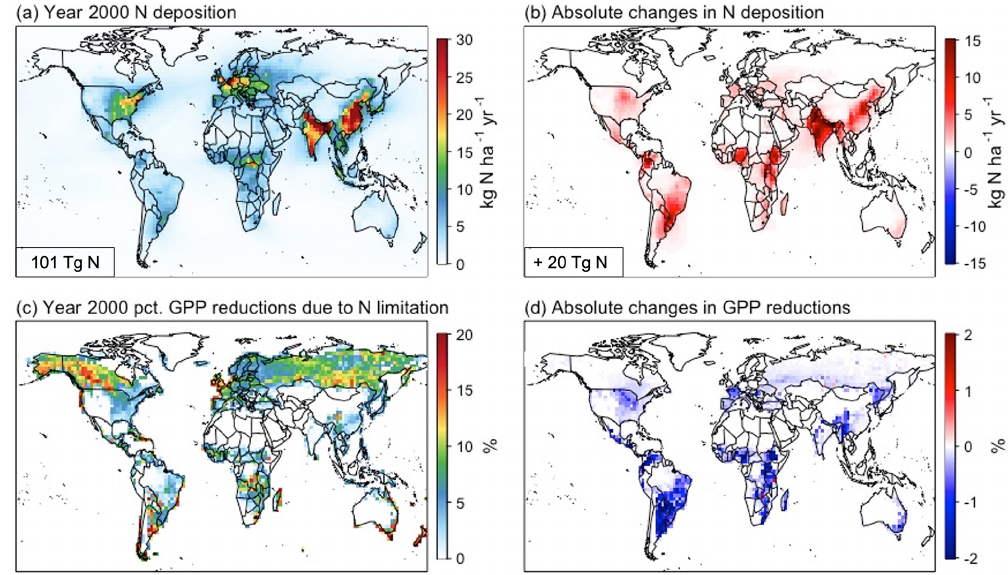
Figure 3. (a) Year 2000 atmospheric nitrogen deposition and (b) absolute changes in nitrogen deposition over year 2000 to year 2050. (c) Year 2000 gross primary production (GPP) percentage reduction, due to nitrogen limitation, as presented in the CLM model. In nitrogen- limited soils (i.e., colored areas), plant growth is limited by insufficient soil nitrogen supply due to plant–microbe competition. (d) There are absolute changes in nitrogen-limitation-induced GPP reductions because of enhanced nitrogen availability from atmospheric nitrogen deposition over 2000–2050. Relative changes over 2000–2050 can be found in Fig.